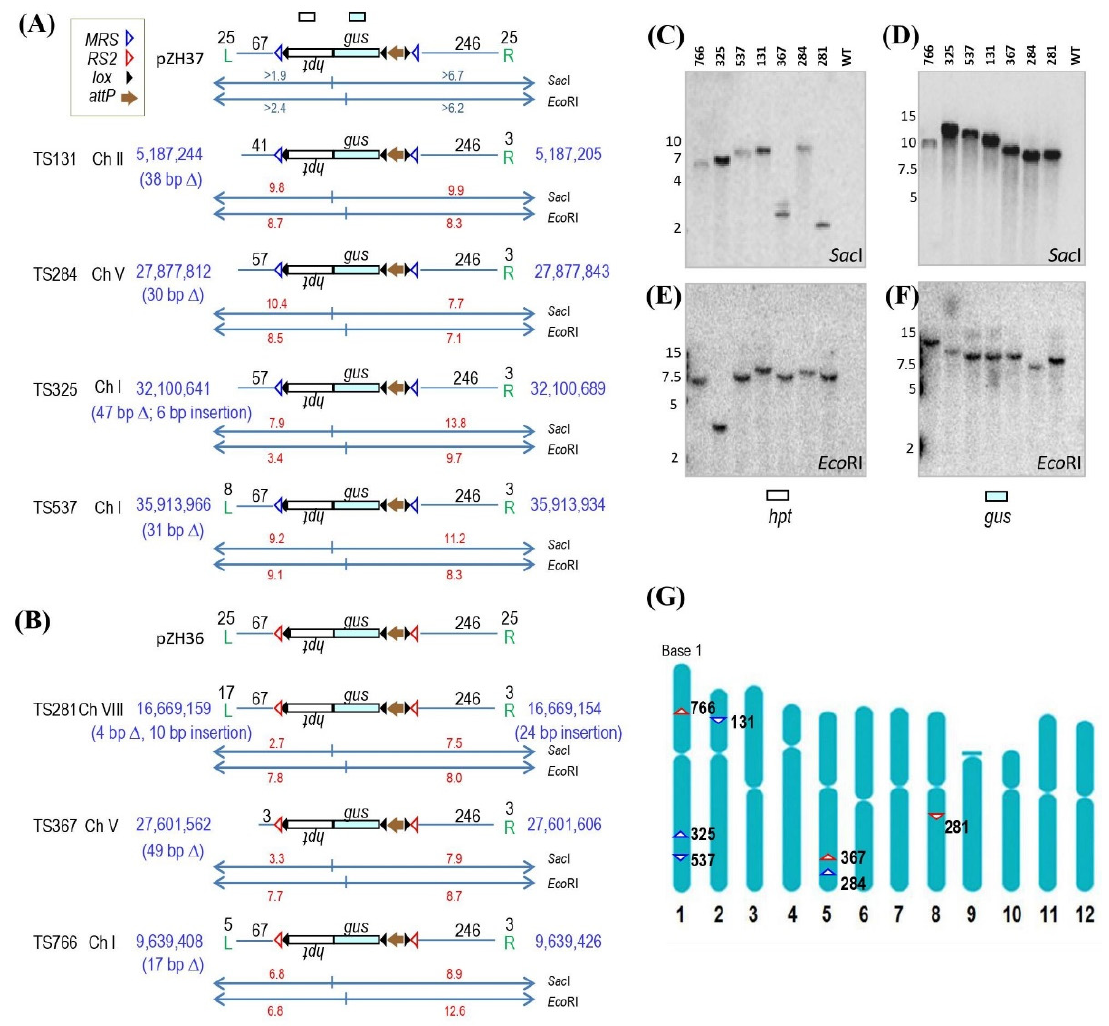
Figure 1. Genome structure and location of rice target lines. ( A , B ) Schematic representation of target site structures derived from pZH37 ( A ) and pZH36 ( B ). Blue lettering indicates chromosome positions at left and right ends and, if any, chromosome deletions and insertions in parentheses. Black lettering above L (left) and R (right) T-DNA borders, if present, show the number of L and R bp; between MRS or RS2 to T-DNA ends show number of vector bp. DNA probes hpt and gus shown above pZH37; restriction map for pZH36 is the same as for pZH37. Target line restriction maps calculated from chromosome restriction sites outside of transgenic DNA and sizes shown in red lettering. ( C – F ) Southern blots detected single left end fragment in SacI ( C ) or EcoRI ( E ) cleaved genomic DNA when probed with hpt and single right end fragment in SacI ( D ) or EcoRI ( F ) treated DNA when probed with gus . WT is Oryza sativa cv. Zhonghua 11; size markers on left side of each blot (based on ethidium-bromide-stained gels, not shown). Hybridization probes shown above pZH37; recombination sites indicated in legend; fragments and size markers in kb; genes transcribe left to right except for hpt indicated by upside-down lettering; promoters and terminators not shown, see Materials and Methods. ( G ) Rice genome map from www.ricemap.org; genome coordinates start at the top for each chromosome. Target sites derived from pZH37 and pZH36 shown as MRS and RS2 sites, respectively, with site orientation indicating the orientation of insertion.